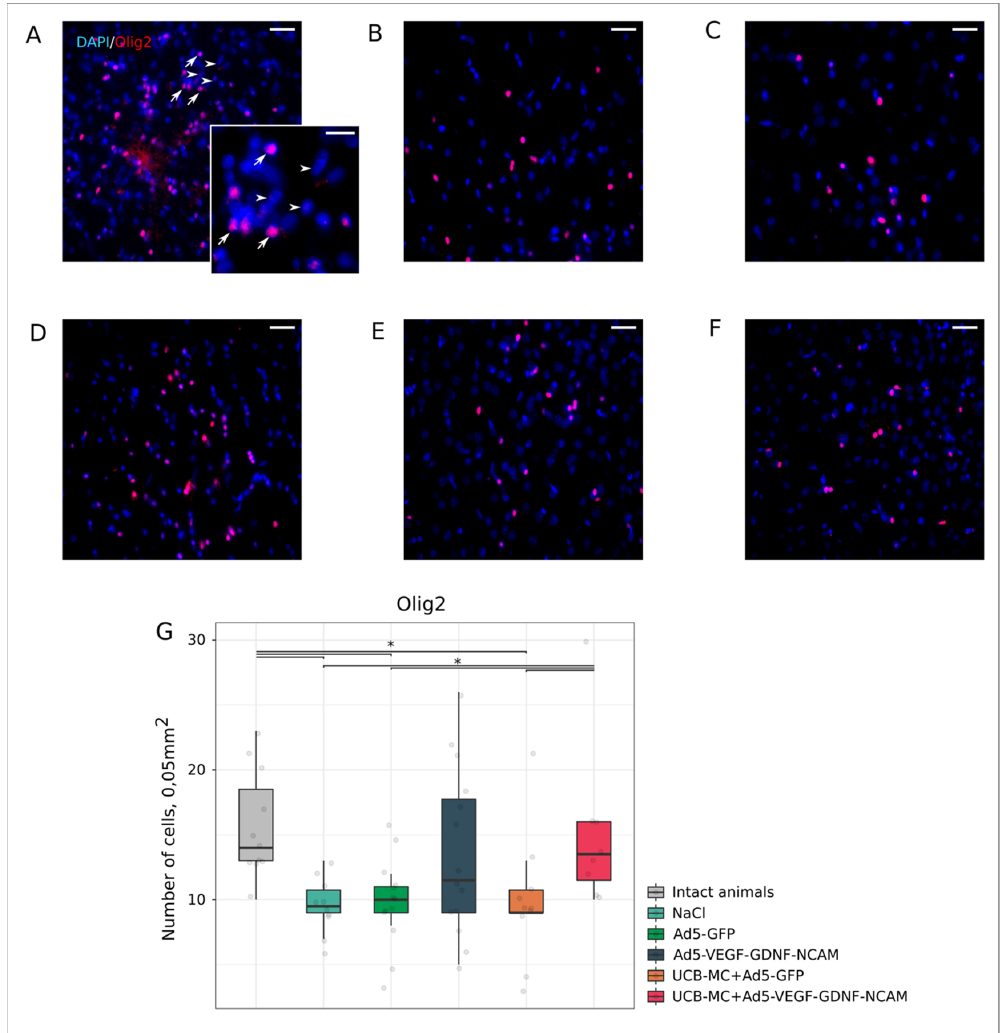
Figure 7. Count of Olig2-positive oligodendrocytes in the rat brain cortex, 21 days after the middle cerebral artery occlusion. Immunofluorescent staining with antibody to oligodendrocyte transcription factor Olig2 (red glow) in intact ( A ), control NaCl ( B ), and Ad5-GFP ( C ), and therapeutic UCB-MC+Ad5-GFP ( D ), Ad5-VEGF-GDNF-NCAM ( E ), and UCB-MC+Ad5-VEGF-GDNF-NCAM ( F ) groups. Arrows indicate nuclear localization of Olig2 (red glow) in oligodendrocytes. Arrowheads point to cell nuclei visualized using DAPI (blue glow). Scale bar in ( A – F ) = 50 µm; scale bar in the insert = 20 µm. ( G )—comparative analysis of Olig2-positive cells number in experimental groups; *— p < 0.05.